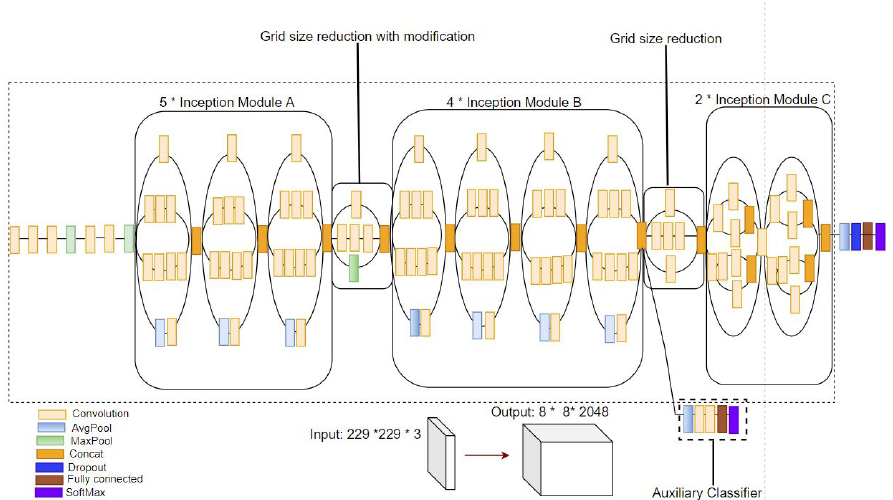
Figure 4. Inception-V3 CNN architecture.